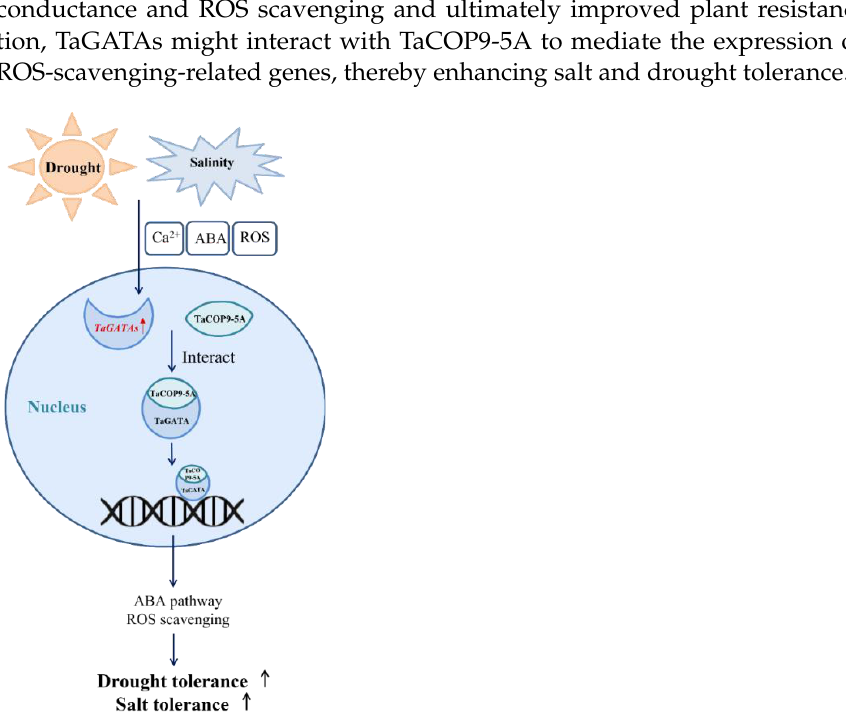
Figure 11. A putative transportation regulatory pathway of TaGATA genes involved in salt and drought tolerance.